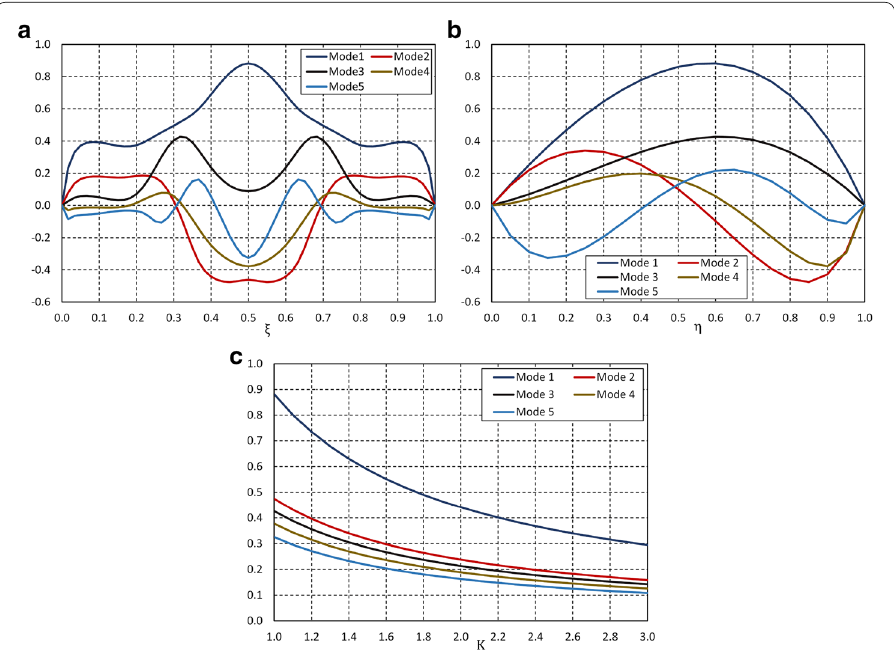
Fig. 14 Modes involved in the separated representation: a modes involving the coordinate ξ ; b Modes involving the coordinate η ; and c Modes involving the thermal conductivity